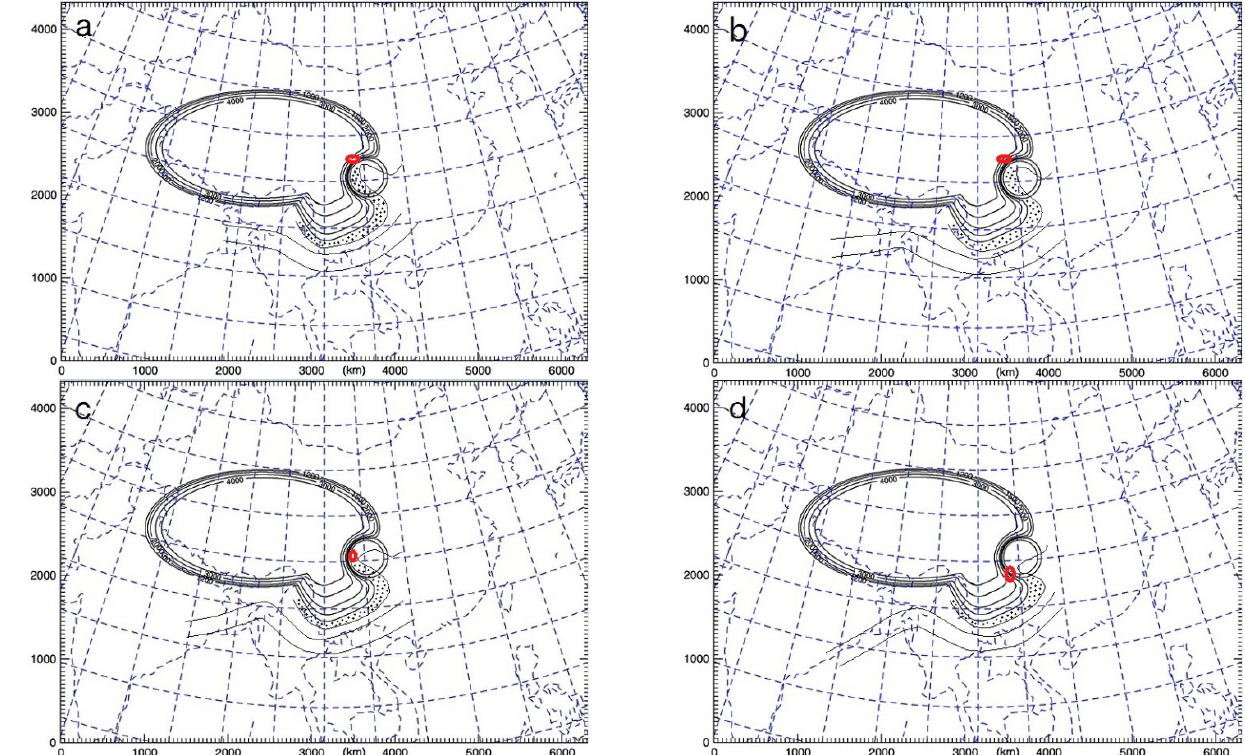
Figure 4. Schematic diagram of the distribution of SWV under different wind situations. The angle between the incoming airflow and the latitude line is 0 ◦ , 15 ◦ , 30 ◦ , and 45 ◦ in ( a – d ), respectively. The location marked with dots is the Prandtl boundary layer, and the red ellipse is the position of the vortex source, U ∞ = 22 ms − 1